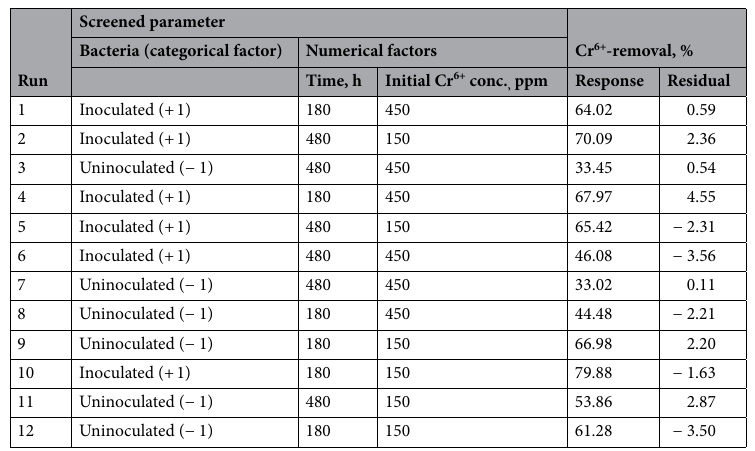
Table 1. Screening matrix of the Plackett–Burman design with the corresponding Cr 6+ removal by P. alcaliphila